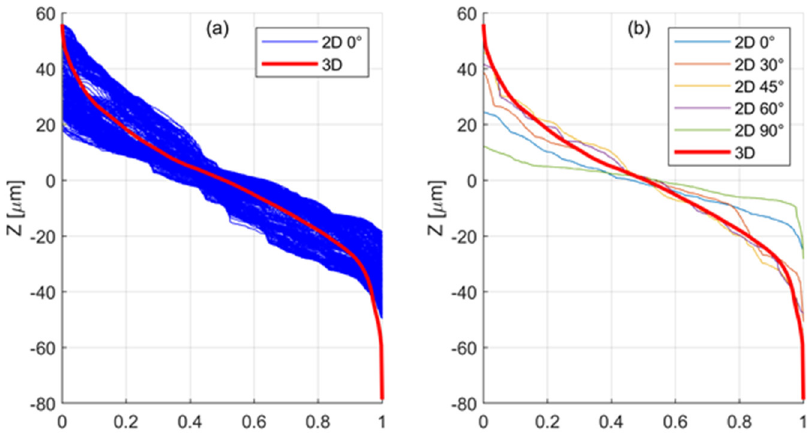
Figure 5. Comparison between material ratio curves evaluated in 2D and in 3D (red); ( a ) 3D curve compared to the band generated by 2D curves and ( b ) 3D curve compared with five 2D curves collected along different directions.